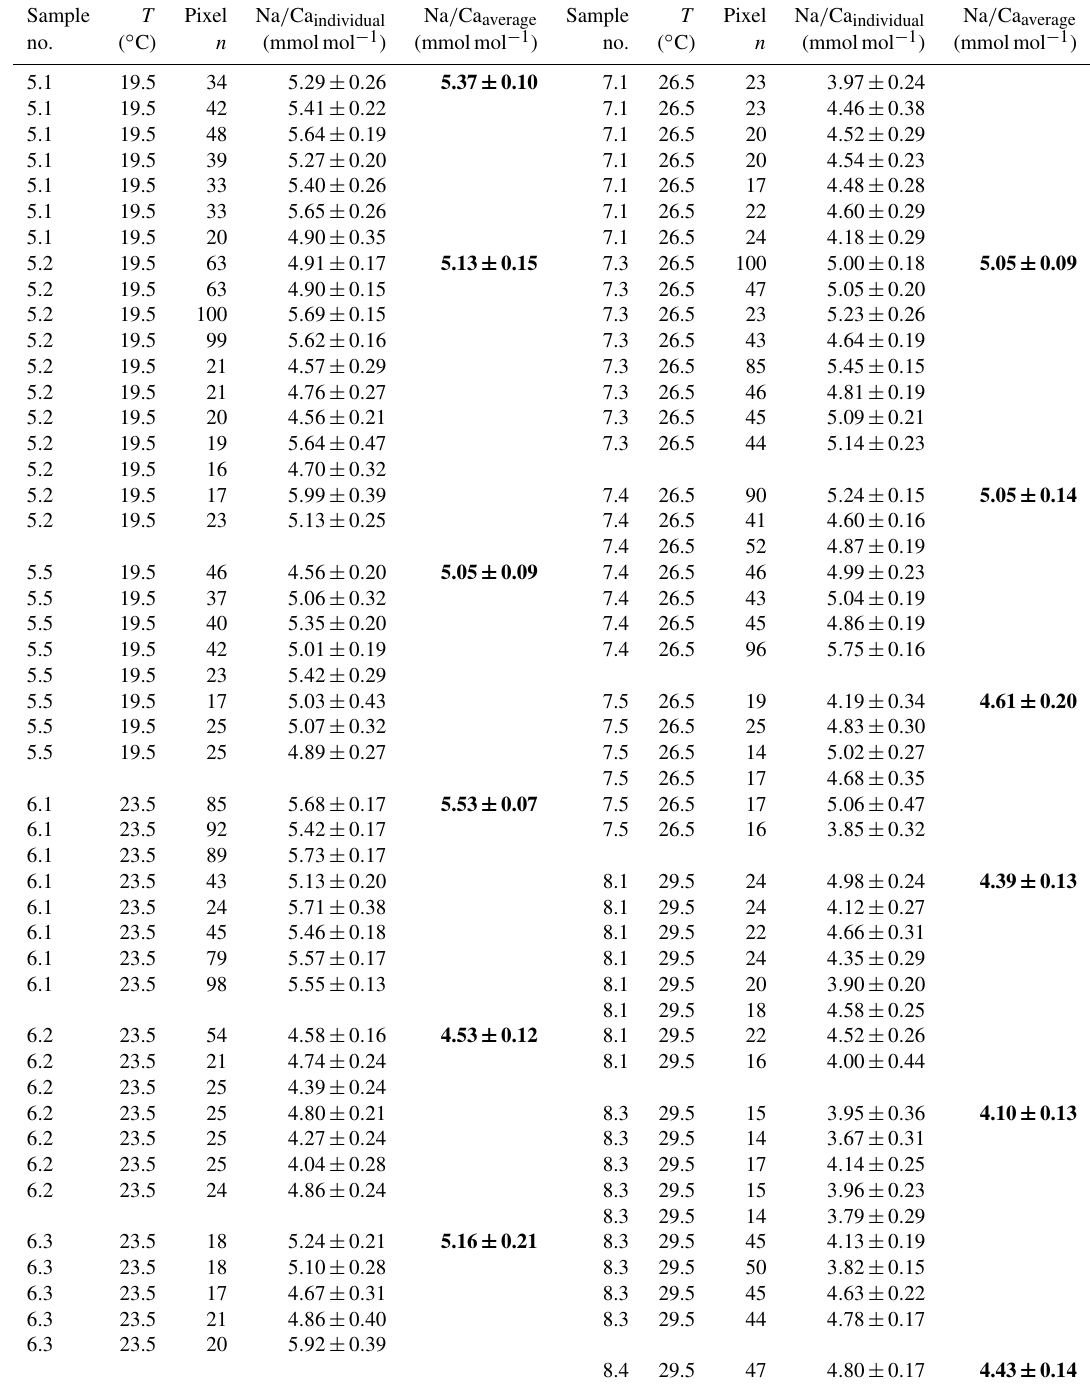
Table 5. Individual Na / Ca values of cultured T. sacculifer under variable temperatures ( T ) and a constant salinity of 33, measured by the electron microprobe. Each value results from maps, ranging in size from 5 to 20µm, on inner chamber wall cross sections of newly grown calcite (F, F-1) during the experiments. Each pixel represents 1µm × 1µm. Averaged values (bold) comprise all Na / Ca values of one single foraminifer. Sample labels correspond to those used in Nürnberg et al. (1996). Individual and averaged Na / Ca values are based on ± standard √ n error of the mean ( σ/